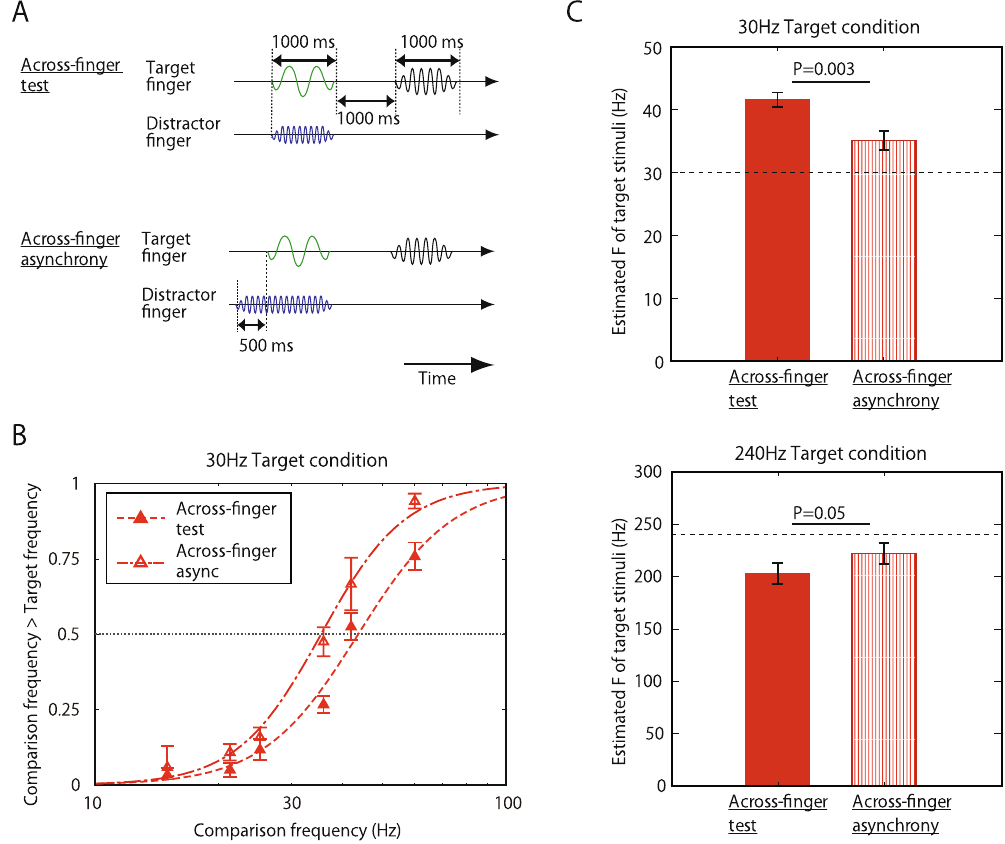
Figure 3. Effect of onset timing in frequency interaction Across-finger. ( A ) Trial sequences for each distractor condition, when the target frequency was 30 Hz. The onset of the distractor vibration was 500 ms earlier than that of the target vibration, and offsets of these two vibrations were the same. ( B ) Psychometric functions of 30-Hz target condition. N = 10. Error bars indicate ± 1 SEM. ( C ) Perceived frequency of the target vibration of 30 Hz (top) and 240 Hz (bottom). N = 10. Error bars indicate ± 1